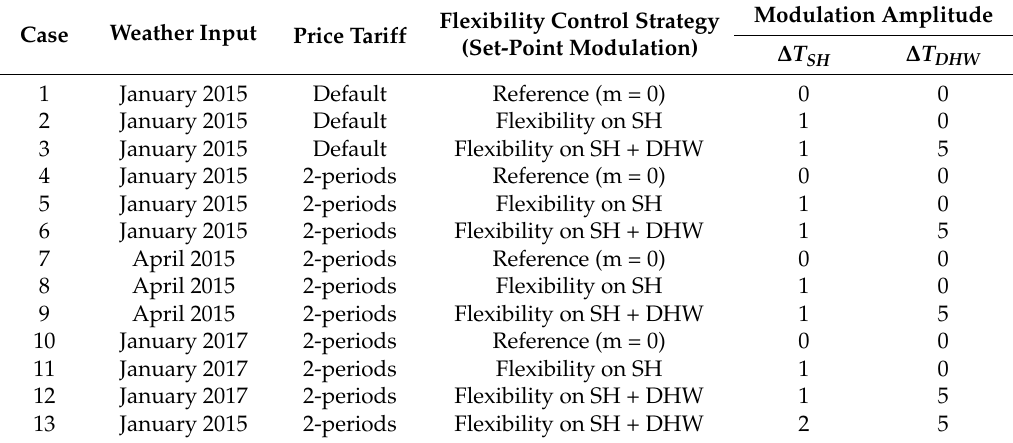
Table 3. List of simulation